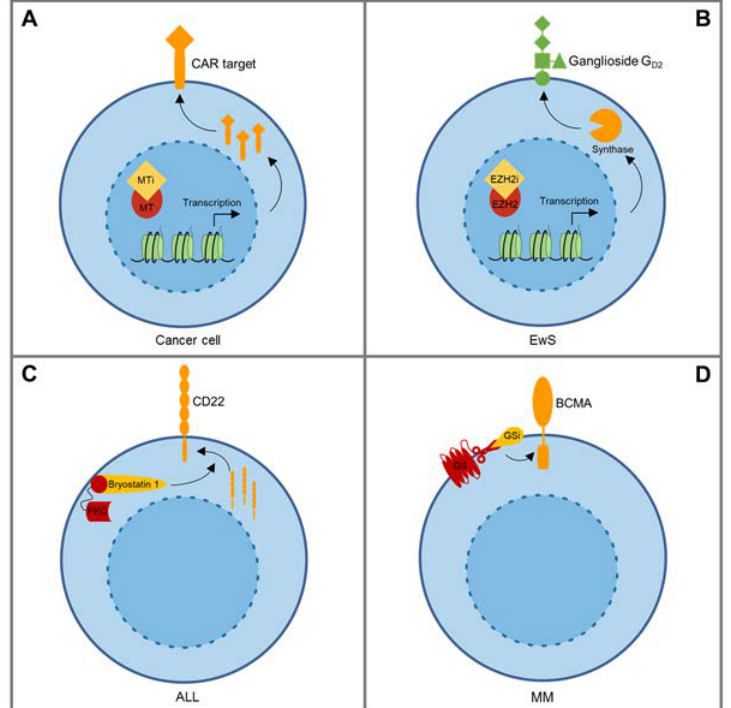
Figure 1. Pharmaceutical agents upregulate CAR target antigen expression in cancer cells by various mechanisms. ( A ) Methyltransferase inhibitors (decitabine, azacytidine) can increase surface expression of chimeric antigen receptor (CAR) targets such as MUC1 in cancer cells [44]. ( B ) EZH2 inhibiting agents induce gene expression of enzymes involved in G D2 synthesis and upregulate G D2 surface expression in GD2-low or G D2 -negative Ewing sarcoma cells [56]. ( C ) Bryostatin1, a protein kinase C (PKC) modulating agent, increases CD22 surface expression by an unresolved mechanism proposed to involve changes in membrane trafficking [47]. ( D ) Small-molecule γ -secretase (GS) inhibitors (GSI) prevent cleavage of the CAR target BCMA from the surface of multiple myeloma cells [57].